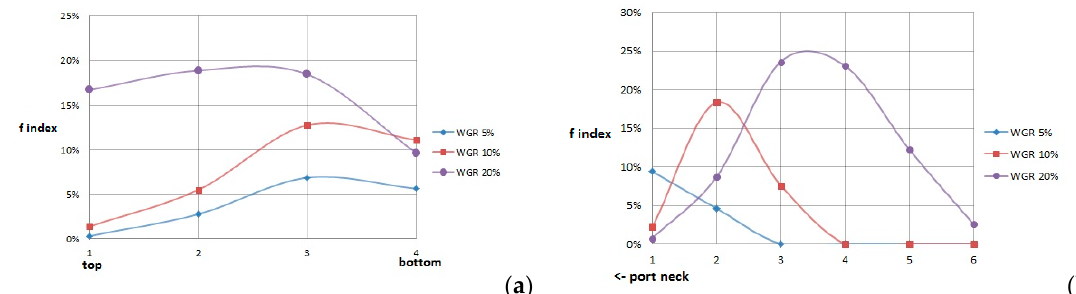
Energies 2019 , 12 , x FOR PEER REVIEW 11 of 17 Figure 12. O 2 mass fraction and specific flow rate for 10% WGR—( a ) port neck section ( b ) checkers